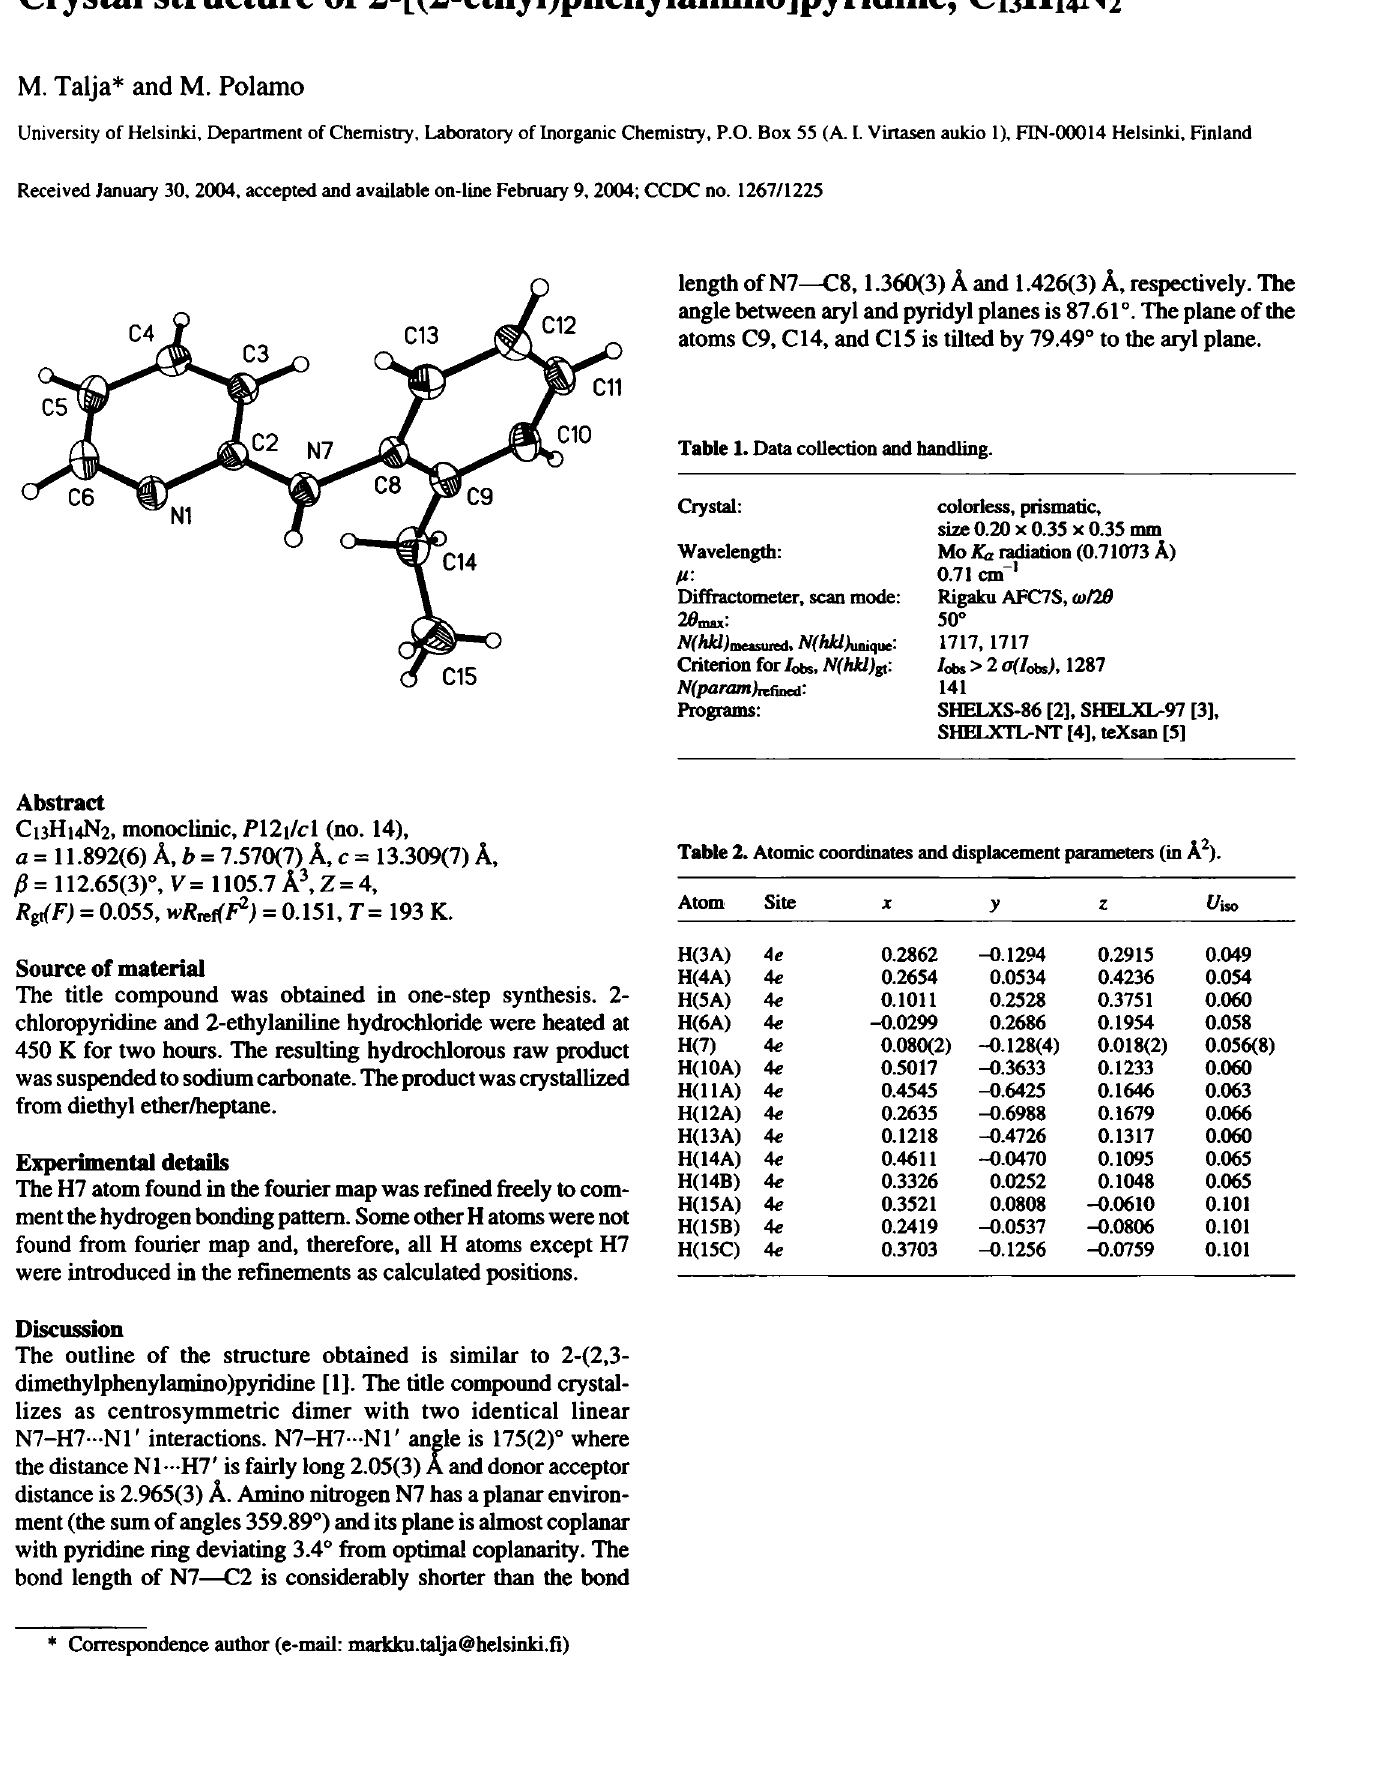
Table 2. Atomic coordinates and displacement parameters (in Â 2